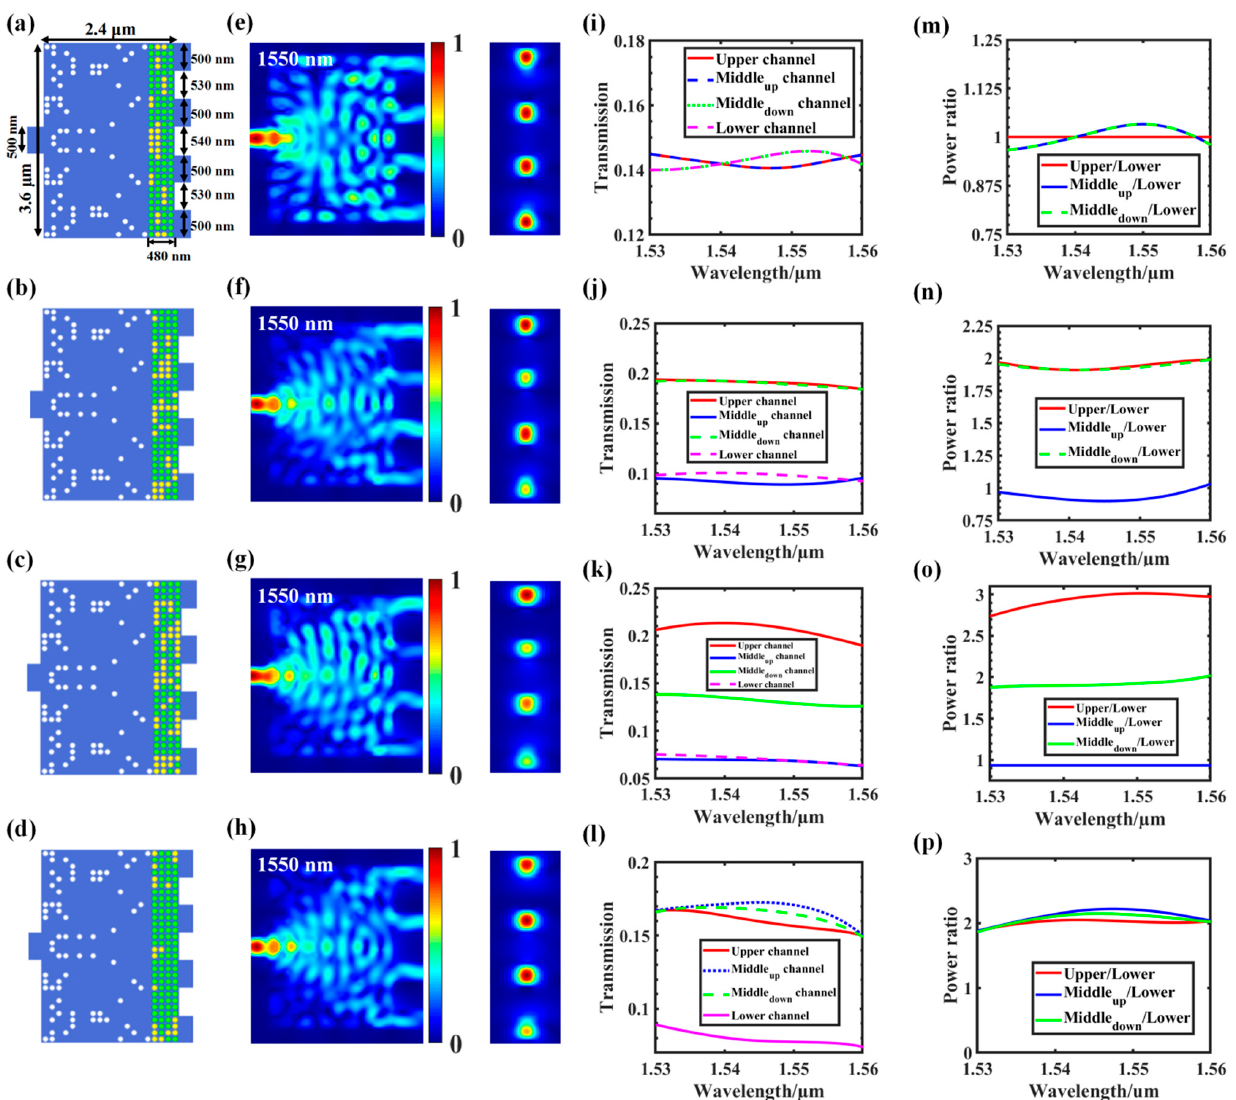
Figure 8. Design of a four-channel programmable arbitrary power splitter: ( a – d ) structure diagram of a 1 × 4 power splitter with 1:1:1:1, 2:1:2:1, 3:1:2:1, and 2:2:2:1 split ratios; ( e – h ) light field distribution at 1550 nm of the upper, middle up , middle down , and lower channels; ( i – l ) transmission spectra of all tested channels; ( m – p ) simulated power–split ratio for the 1 × 4 splitter, where the red line indicates the simulated power ratio between the upper and lower channels in the wavelength range of 1530–1560 nm. The blue line indicates the ratio between the middle up and lower channels. The green line indicates the ratio between the middle down and lower channels.